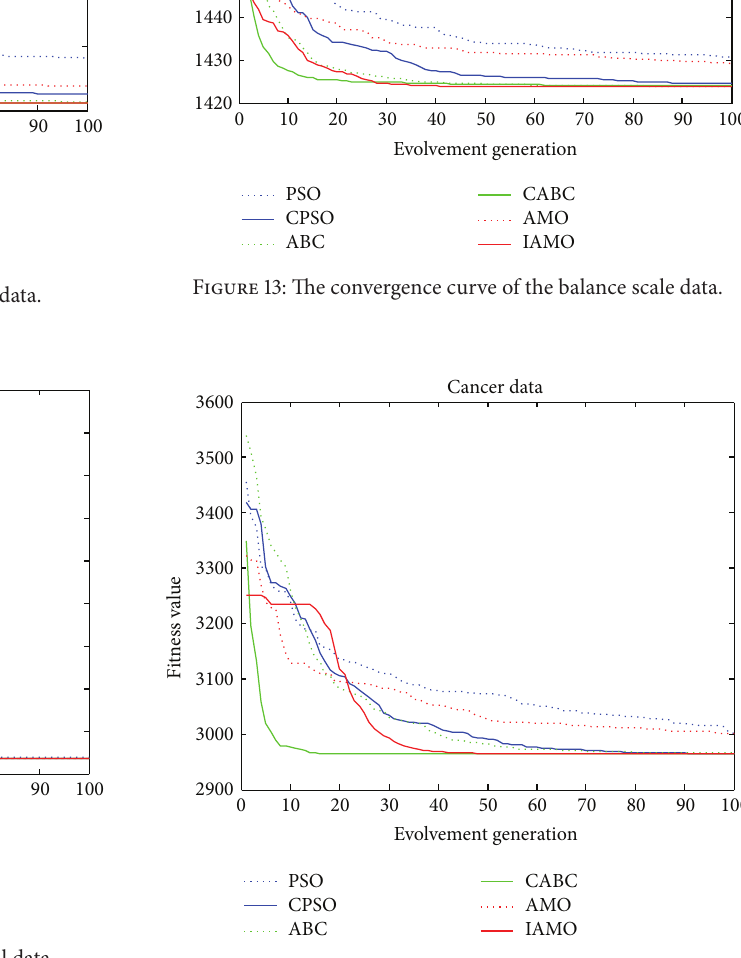
So the best 𝜌 for solving Iris data set must exist between 0.7 and 0.99.